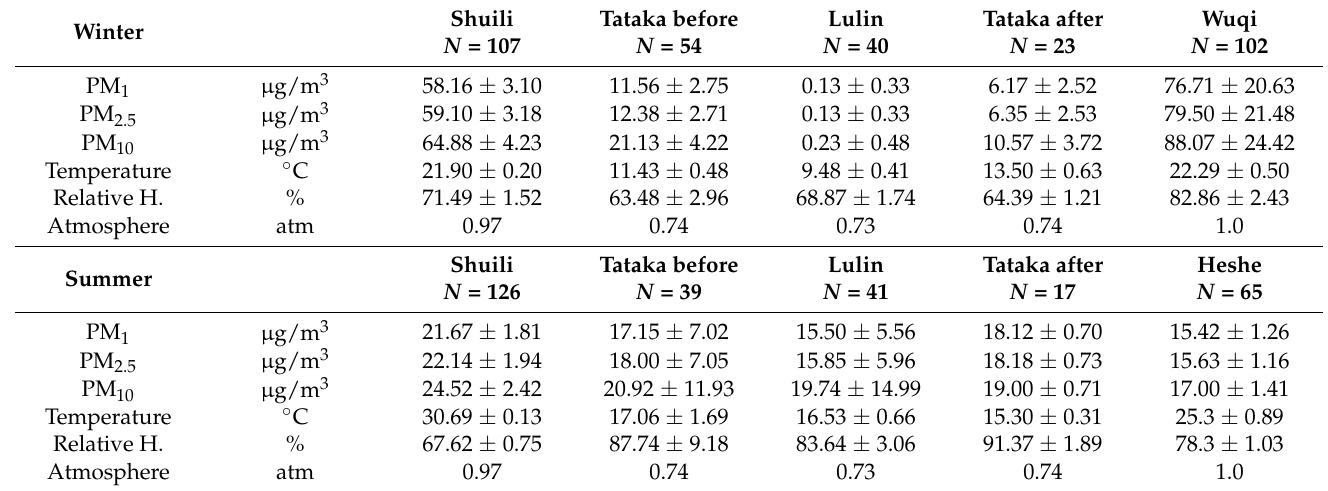
Table 2. Environmental and air quality